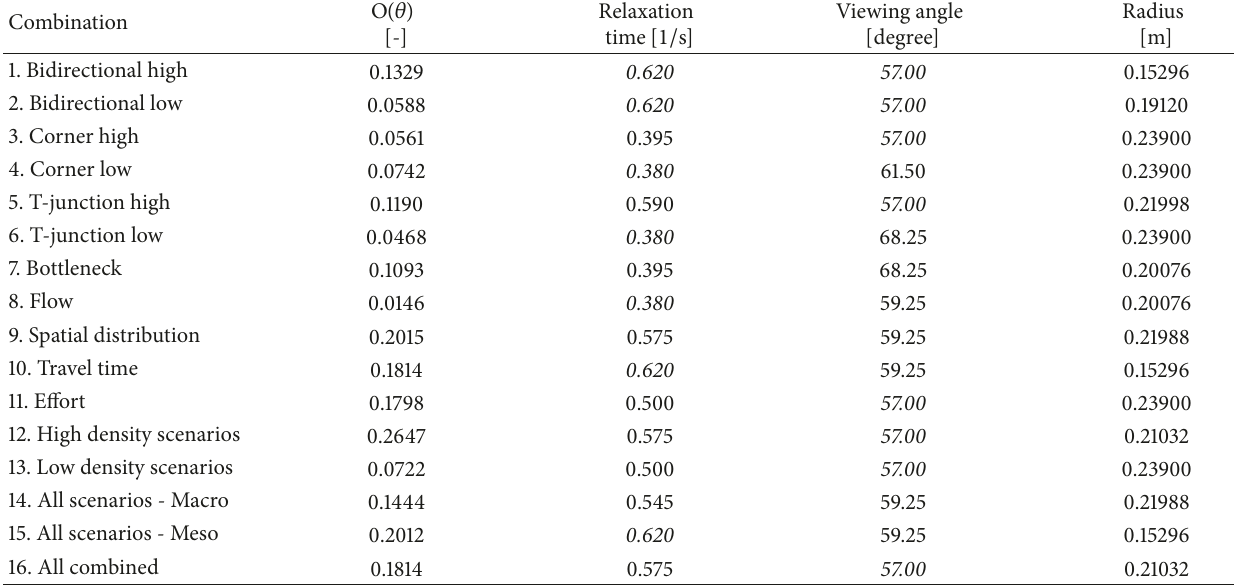
Table 4: Calibration results, where 𝑂(𝜃) represents the optimal value of the objective function. The cells in italic font indicate that the value is at the upper or lower boundary of the search